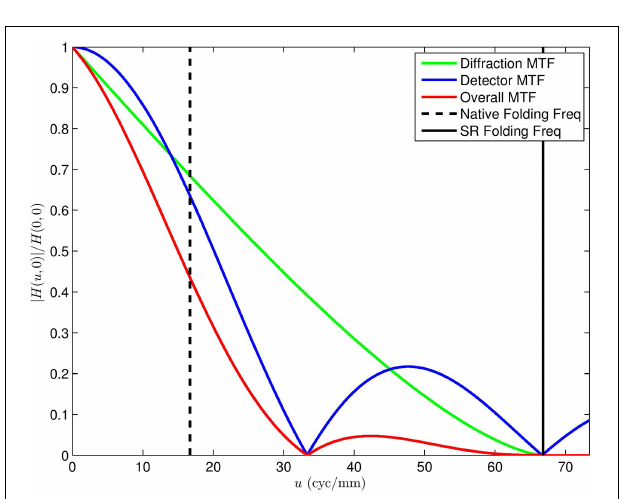
FIGURE 11 | Cross section of the MTF for Figure 10. The diffraction and detector component of the overall MTF can be clearly seen. The native folding frequency for p = 30 μ m (100% fill factor, Q = 0 . 5 ), is shown along with the L = 4 SR folding